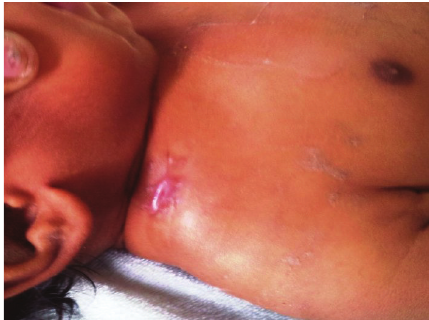
Figure 3: Clinical photograph of the right shoulder showing wound healed by secondary intention.